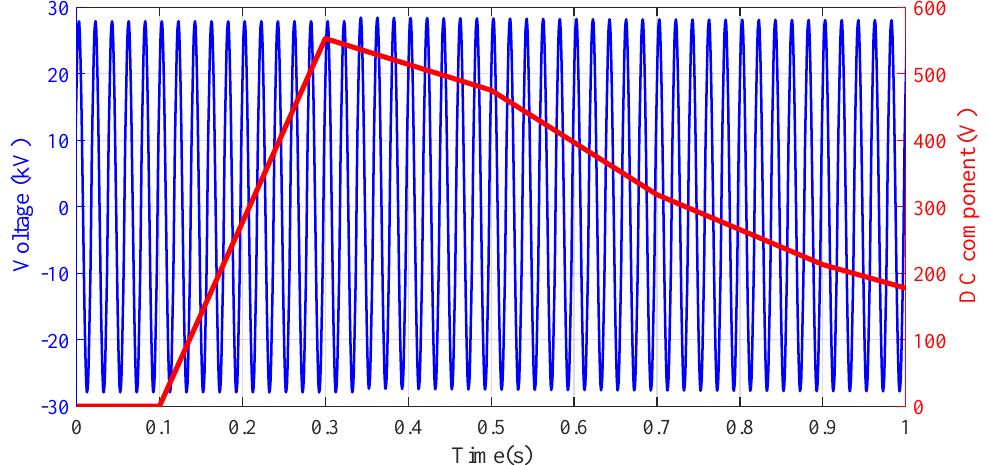
Figure 3. Example of a generated DC transient disturbance with A = 2% and τ = 0.5